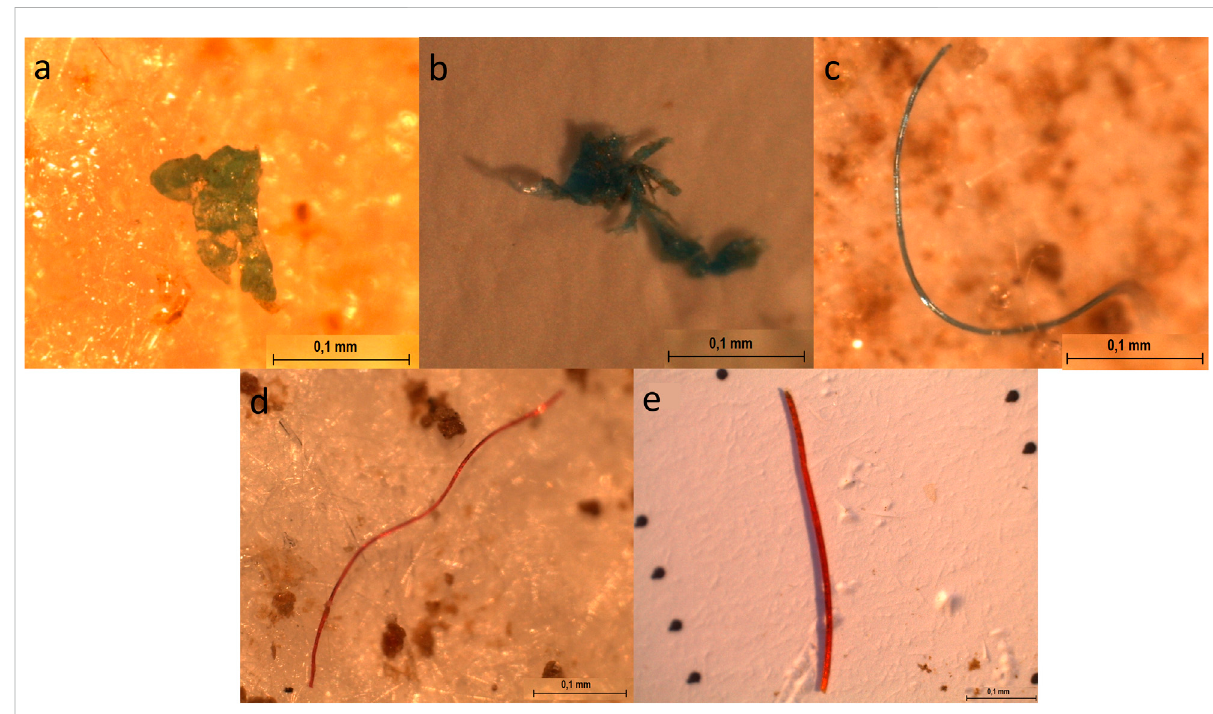
FIGURE 2 Examples of microplastics identi fi ed in the Pantanal wetlands. (A) PVA (green fragment); (B) PP (blue fragment); (C) NIS (blue fi bre); (D) PET (red fi bre); (E) PET (pink fi bre).